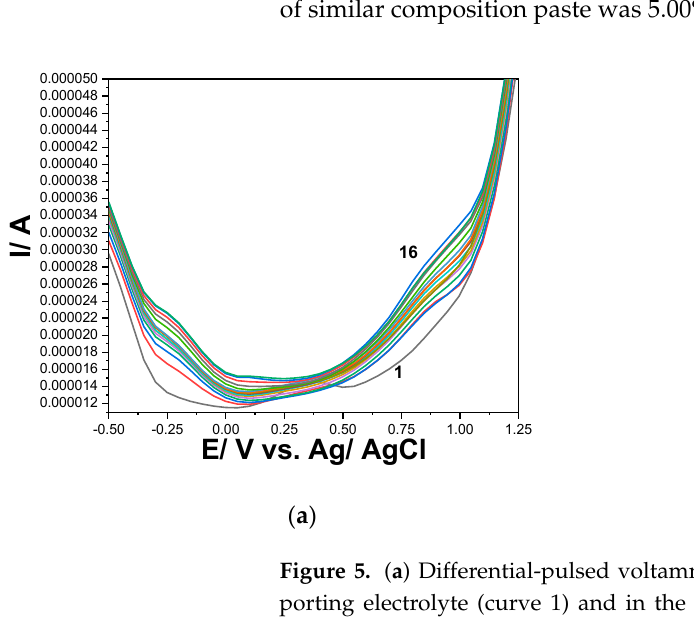
[a] LOD—the lowest limit of detection, LQ—limit of quantification. [b] RSD—relative standard deviation. * cathodic signal. cyclic voltammetry (CV). differential-pulsed voltammetry (DPV). square-wave voltammetry (SWV). multiple-pulsed am- perometry (MPA).